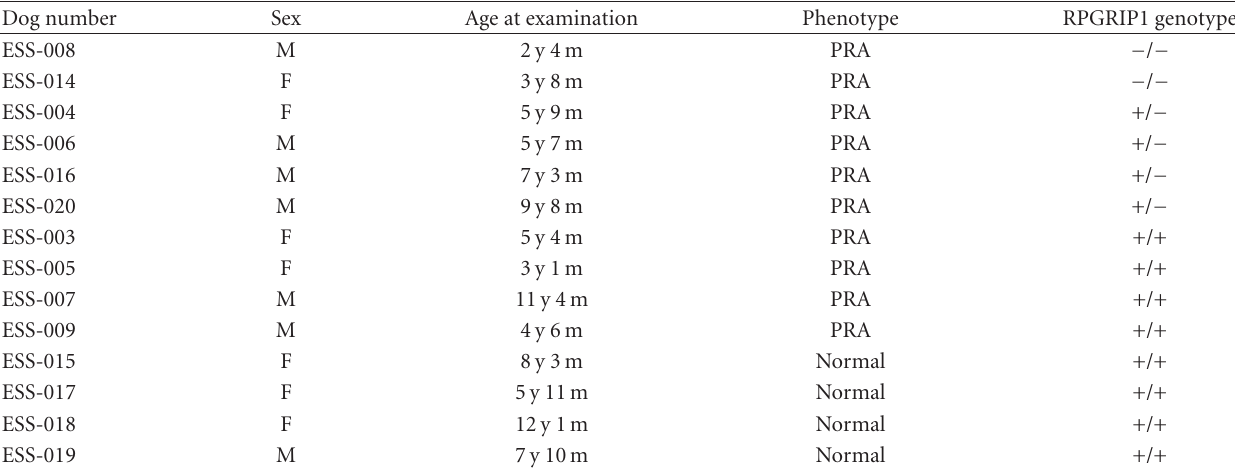
Table 1: Swedish ESS dogs with genotype-phenotype correlation in regards to the RPGRIP1 mutation. The sex of the dogs is indicated as M for males and F for females. The age of diagnosis is shown as years (y) and months (m) when dogs were first examined and diagnosed with PRA. For the dogs without PRA (normal), the most recent examination dates were used for age at examination. The genotypes are given as − / − for genetically a ff ected, +/ − for carriers, and +/+ for genetically clear individuals of the 44bp deletion in exon 2 of the RPGRIP1 gene. Dog number Sex Age at examination Phenotype RPGRIP1